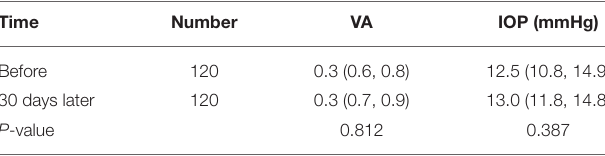
TABLE 3 | Changes in CFS score, eyelid margin changes, MG expressibility, meibum quality, MGDR, blink frequency, and incomplete blink proportion before and after treatment. Time Number CFS score Eyelid margin MG expressibility Meibum quality MGDR (upper signs